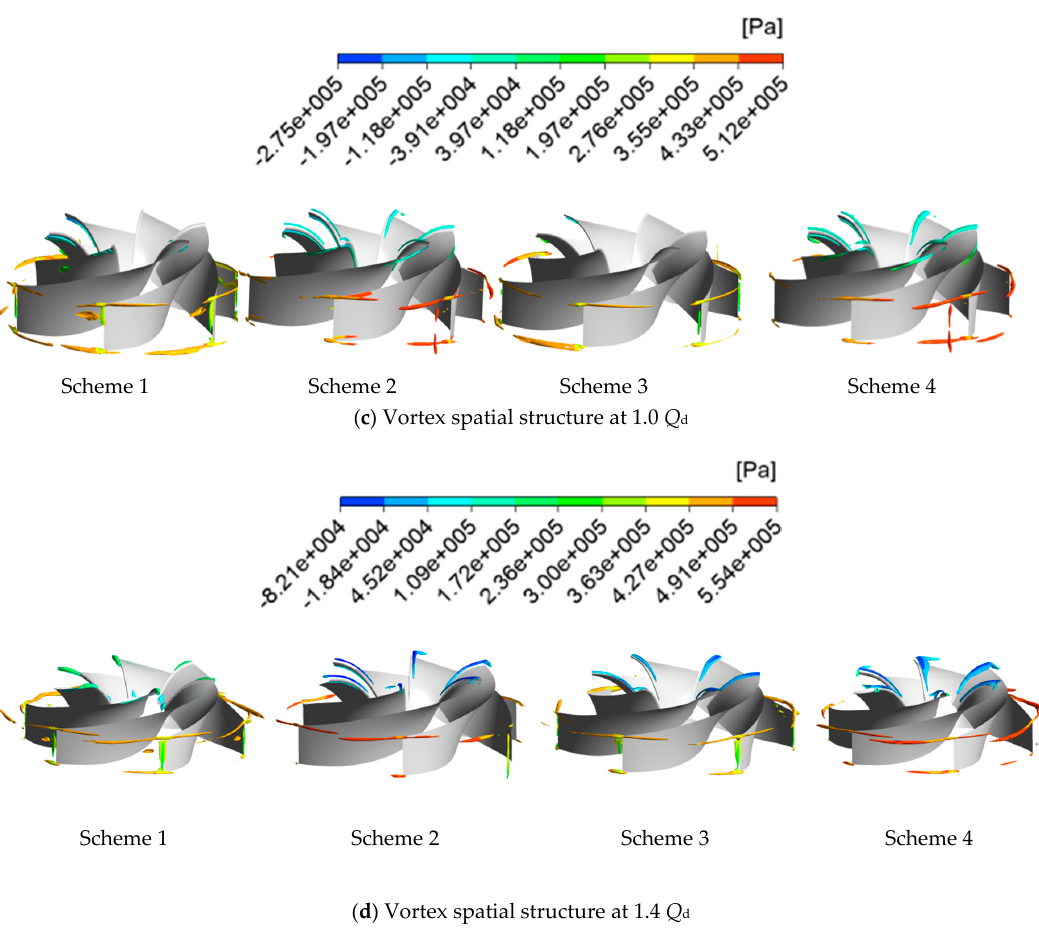
Figure 10. 3D vortex structure for various flow conditions for four different blade thickness Figure10. 3D vortexstructure forvarious flow conditionsfor four di ff erentblade thickness distributions.